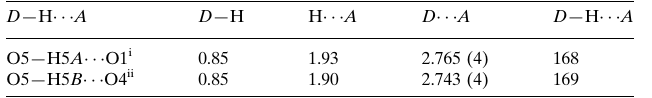
Hydrogen-bond geometry (A˚ , (cid:1)